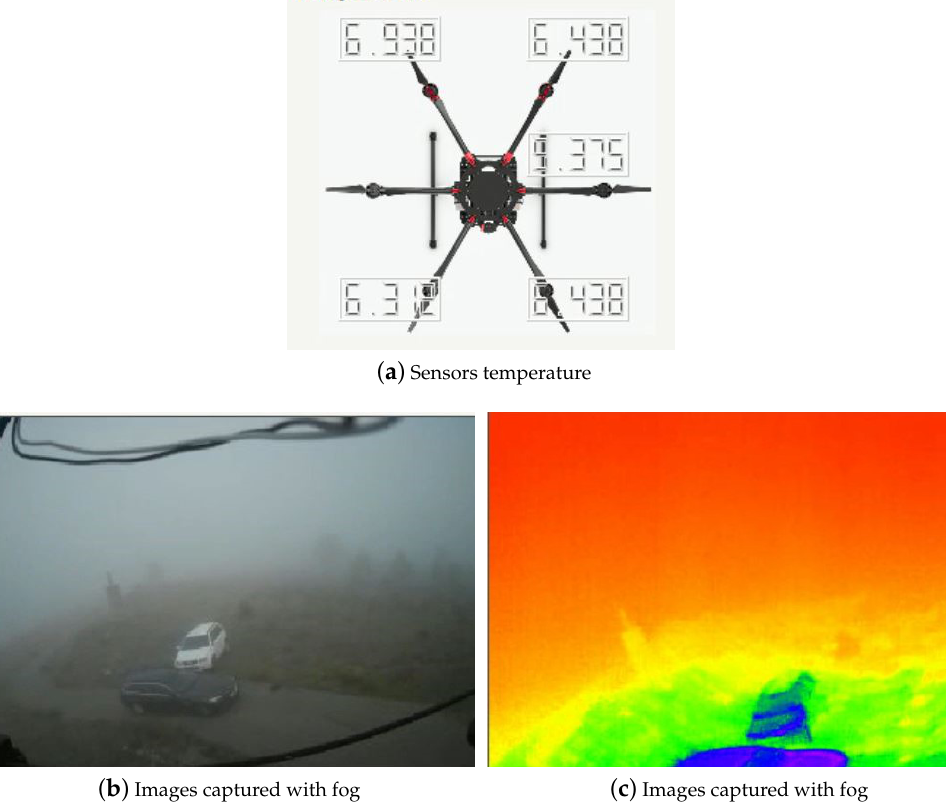
Figure 12. Experimental tests in adverse meteorologist